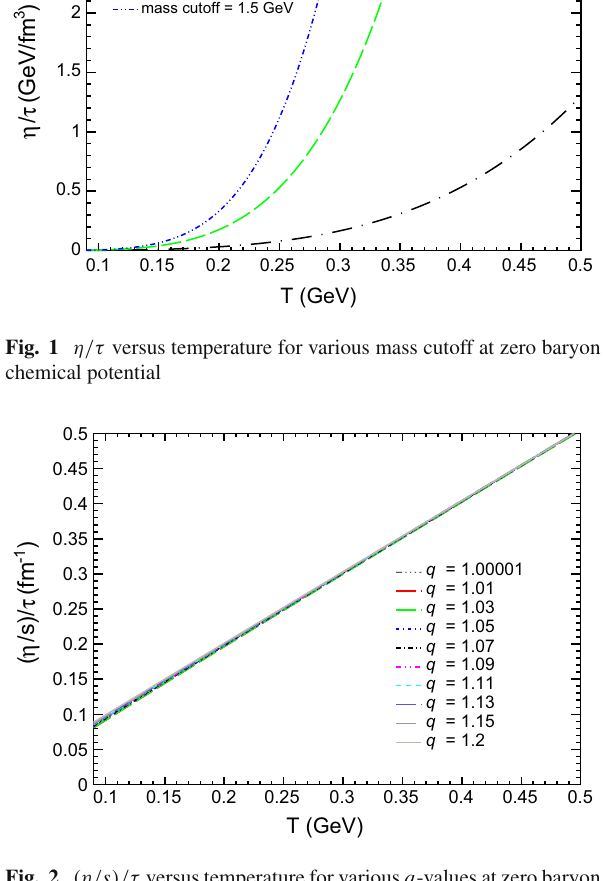
onances into the system, η/τ increases rapidly at a lower T .